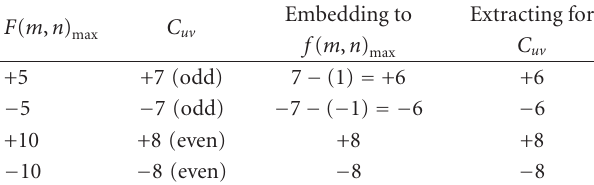
and C uv with the same sign. max